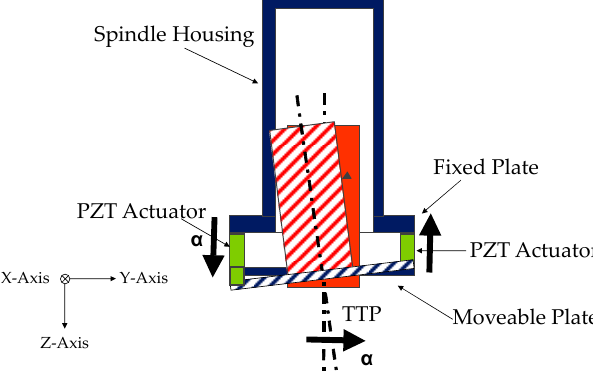
Figure 3. Module functional concept.